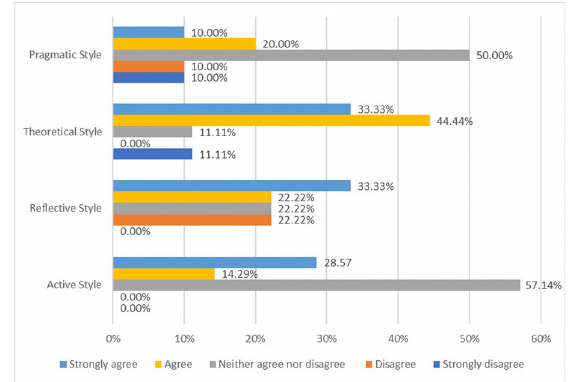
Figure 13. My teacher takes into account my strengths, weaknesses and